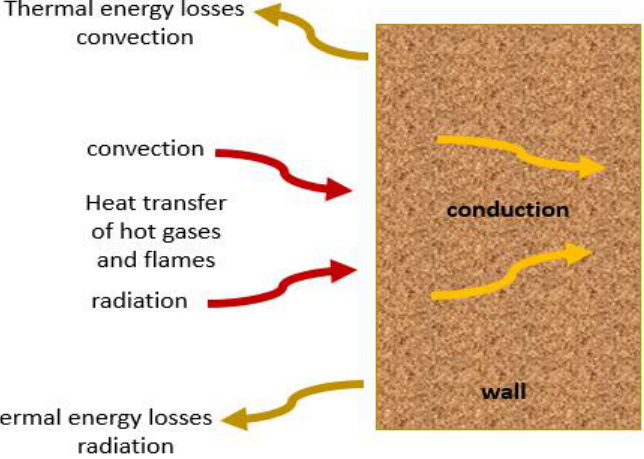
Figure 5. A summary of heat transfer processes in the heating up a wall.